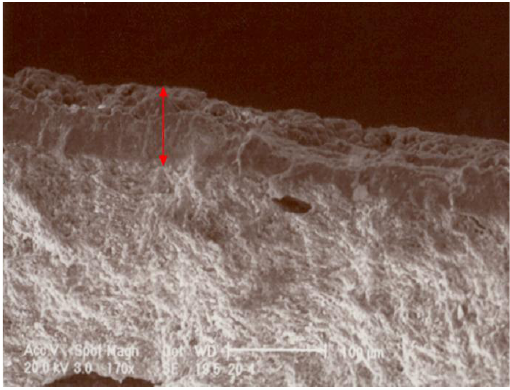
Fig. 10. SEM micrograph of zeolite NaA membrane cross section preparation of kaolin source